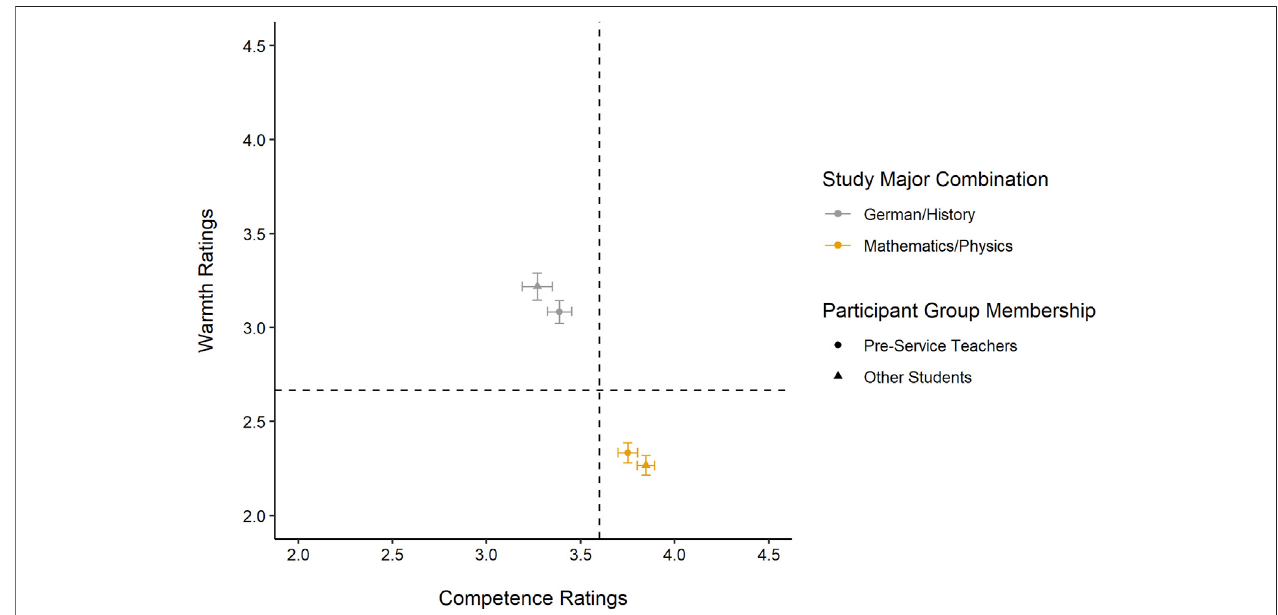
FIGURE3| Competence andWarmthRatingsbyStudyMajorCombinationandParticipantGroupMembershipinStudy3a(Open-Ended Questions).Note.Mean competence and warmth in open-ended questions for different study major combinations rated on a scale from one to fi ve are shown for participants belonging to the groups of pre-service teachers and other students. Error bars represent standard errors. Dotted lines represent the medians of the competence and warmth